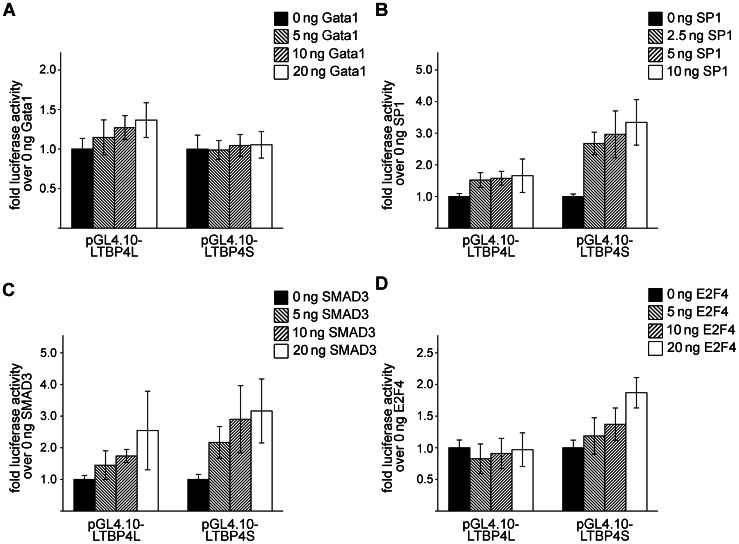
Effect of Gata1, SP1, SMAD3 and E2F4 on transcriptional activity of LTBP4L and LTBP4S promoter.HEK293 cells were transiently transfected with pGL4.10-LTBP4L or pGL4.10-LTBP4S and a Renilla luciferase expression vector for normalization. Cells were also co-transfected with different concentrations of A) a Gata1 expression vector, B) a SP1 expression vector, C) a SMAD3 expression vector or D) an E2F4 expression vector. After 24 h cells were lysed and luciferase activities were determined. Experiments were repeated at least 3 times and the mean value was calculated. Data are presented ± standard deviation.